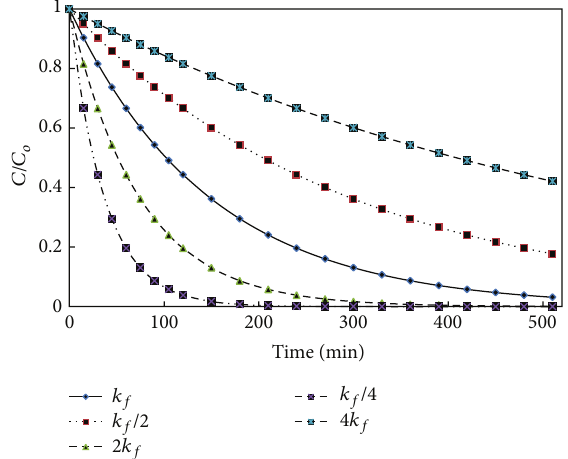
Figure 7: The effect of mass transfer coefficient on the adsorption process for the adsorbent treated with